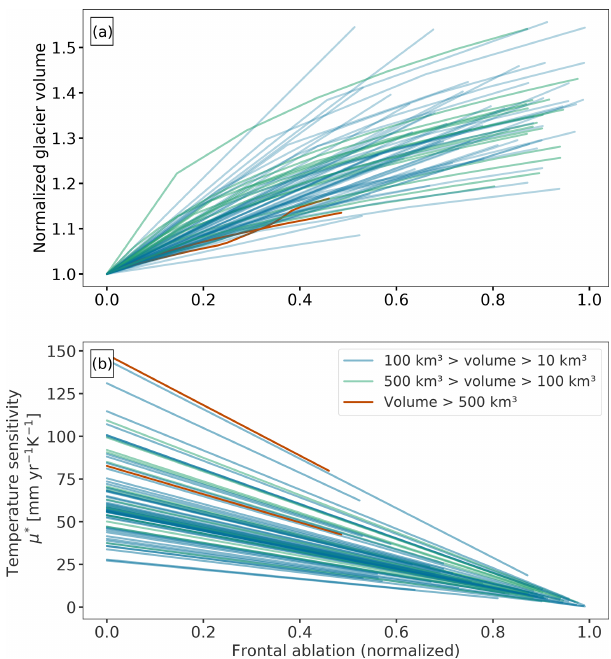
Figure 5. (a) Normalized glacier volume and (b) temperature sensitivity ( µ ∗ ) of individual glaciers, as a function of the pre- scribed frontal ablation fluxes normalized by the total accumulation over each glacier. The different colours represent different glacier classes.